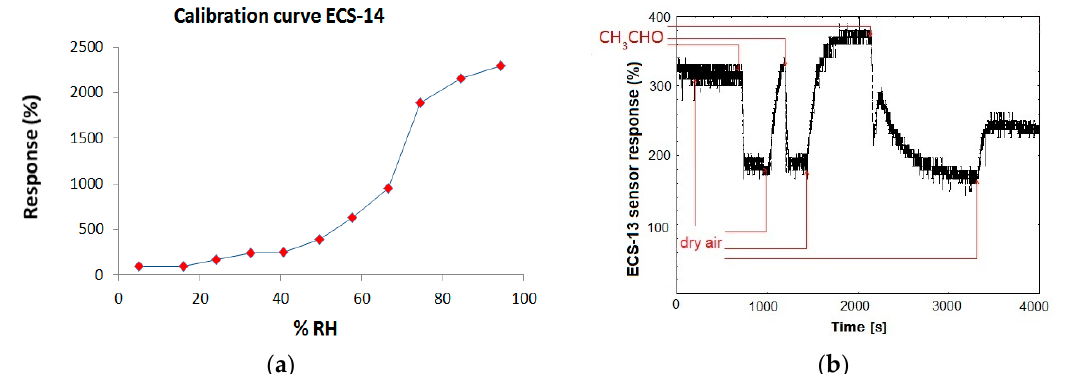
Figure 2. ( a ) The percentage response of ECS-14P film vs. humidity concentration. ( b ) Dynamic response of ECS-13P film tested with 10 ppm of acetaldehyde (CH 3 CHO) in dry